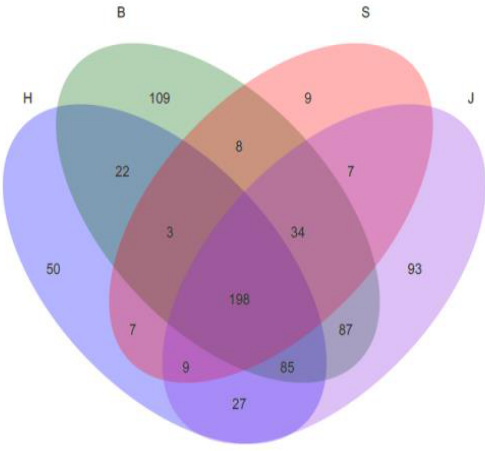
Figure 3. Venn diagram analysis of community distribution. Figure 3 . Venn diagram analysis of community distribution.